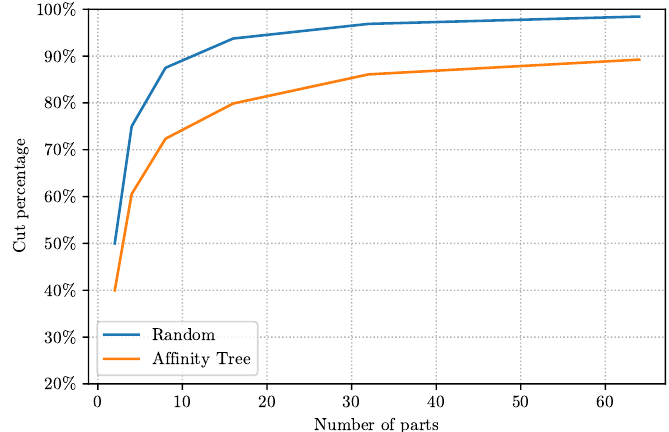
Figure 4. Comparison of the (fully balanced) cut size for RandInit and AffCommNeigh on Twitter .